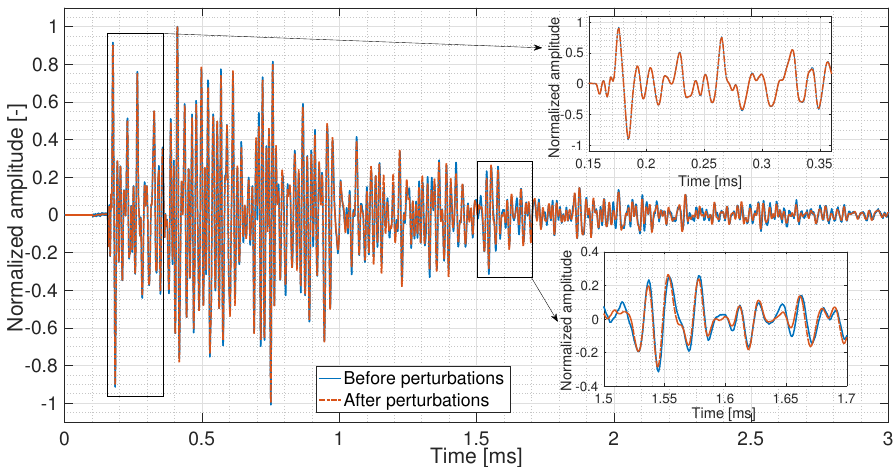
Figure 1. Signals recorded before and after small perturbations in the